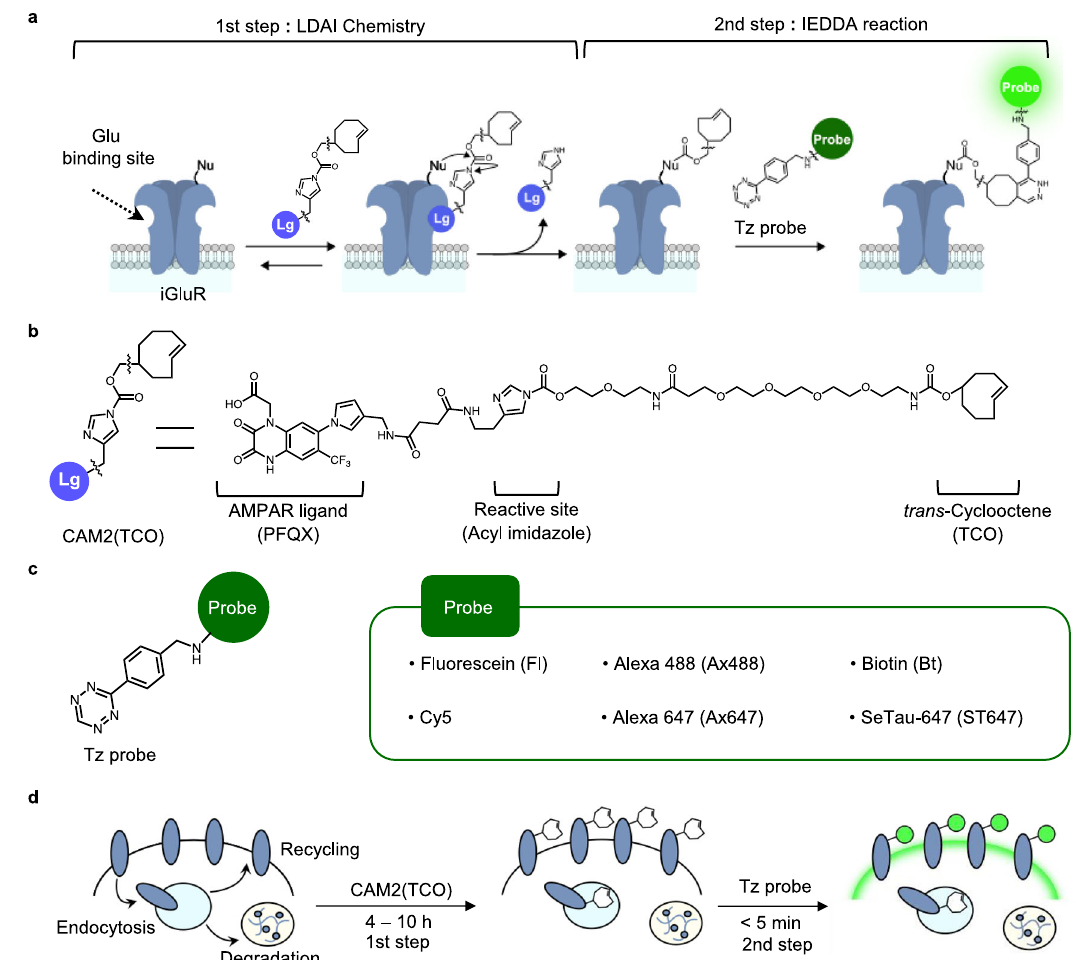
Fig. 1 Rapid labeling of cell-surface iGluRs by ligand-directed two-step labeling. a Schematic illustration of the two-step labeling to iGluRs. In the 1st step, a strained alkene is covalently attached to iGluRs by LDAI chemistry. In the 2nd step, Tz probe is selectively tethered by IEDDA reaction. Lg, selective ligand for iGluRs; Nu, nucleophilic amino acid residue. Glu, glutamate. b Chemical structure of CAM2(TCO). c Chemical structure of Tz probes.